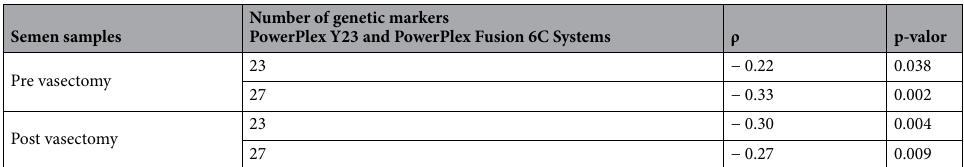
Table 2. Spearman correlation (ρ) between measures of degradation index and count of markers of the PowerPlex Y23 and PowerPlex Fusion 6C Systems, from pre and post vasectomy samples (90